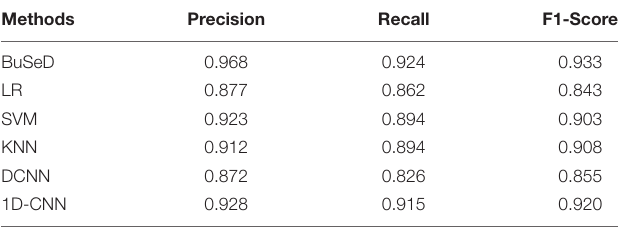
TABLE 3 | Comparison of sentiment classification